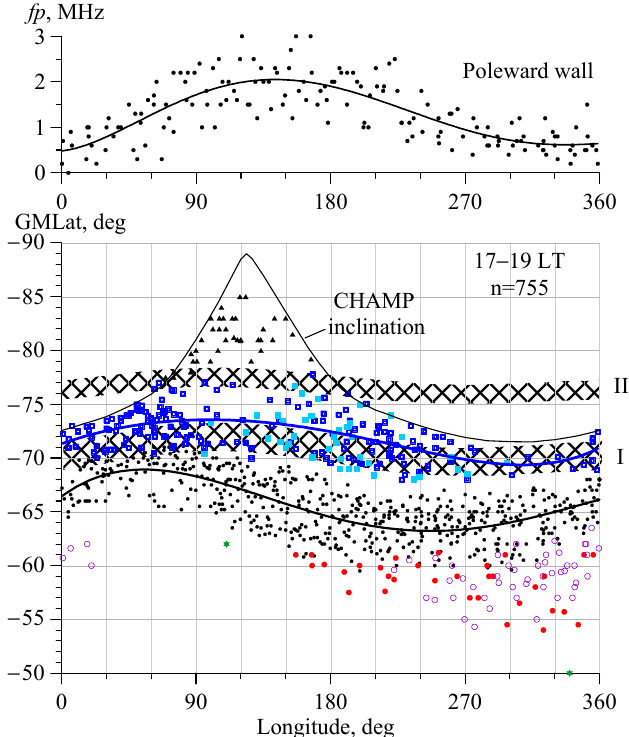
Figure 1. On the top: Longitudinal variations in the magnitude of the MIT poleward wall (dots and approximations). On the bottom: Longitudinal variations in the positions of main structures in the evening winter ionosphere of the southern hemisphere: polar hole (triangles), HLT1 (empty squares), HLT2 (filled squares), MIT (dots), RIT (red dots), equatorward density minima (purple circles), and low-latitude structures (green asterisks). The shaded latitude belts show diffuse auroral precipitation in zones I and II. The upper curve represents the CHAMP inclination equal to 87°.